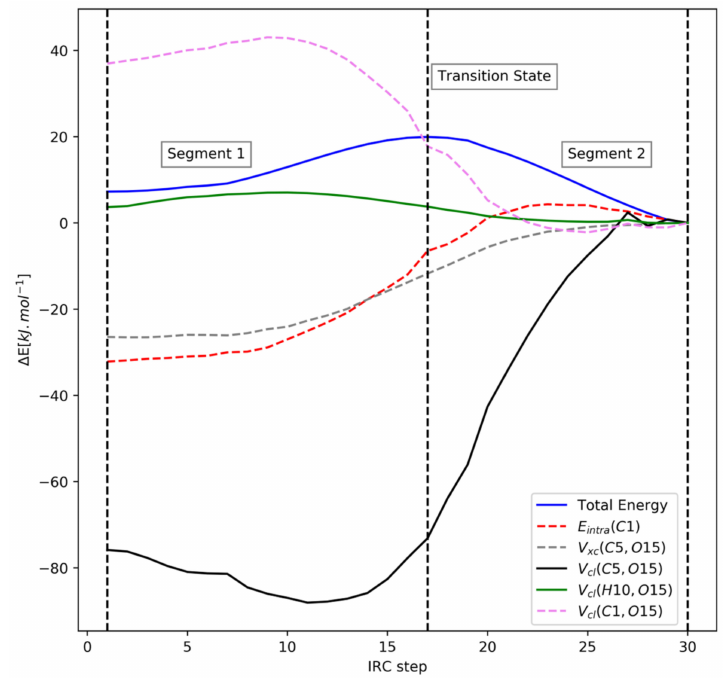
Figure 9. Visualization of the same energetic terms (of the R isomer) in the S isomer.